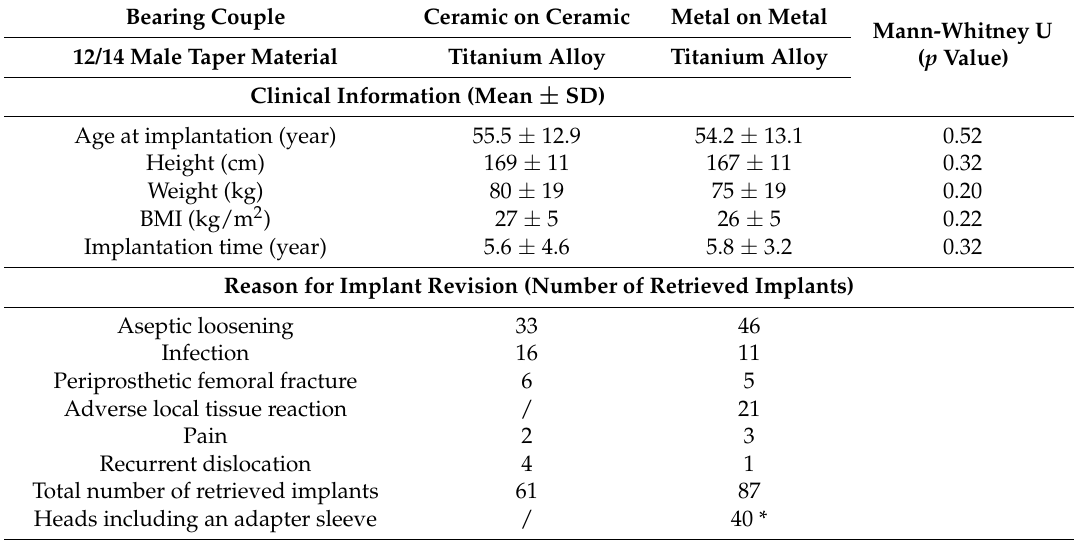
Table 1. Clinical information and reasons for revision for all 148 retrieved